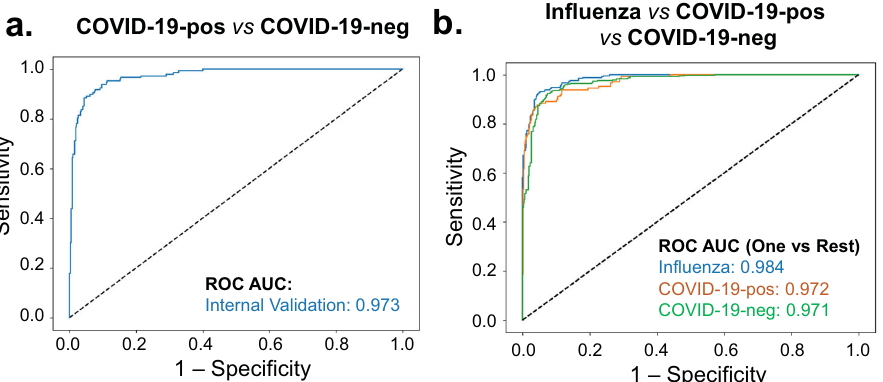
Fig. 2 Receiver operating characteristic (ROC) curves for COVID-19-positive vs COVID-19-negative and multi-class predictive models. Area under the ROC curve showing the predictive performance of the a COVID-19-positive versus COVID-19-negative, and b in fl uenza versus other prediction models on the internal validation